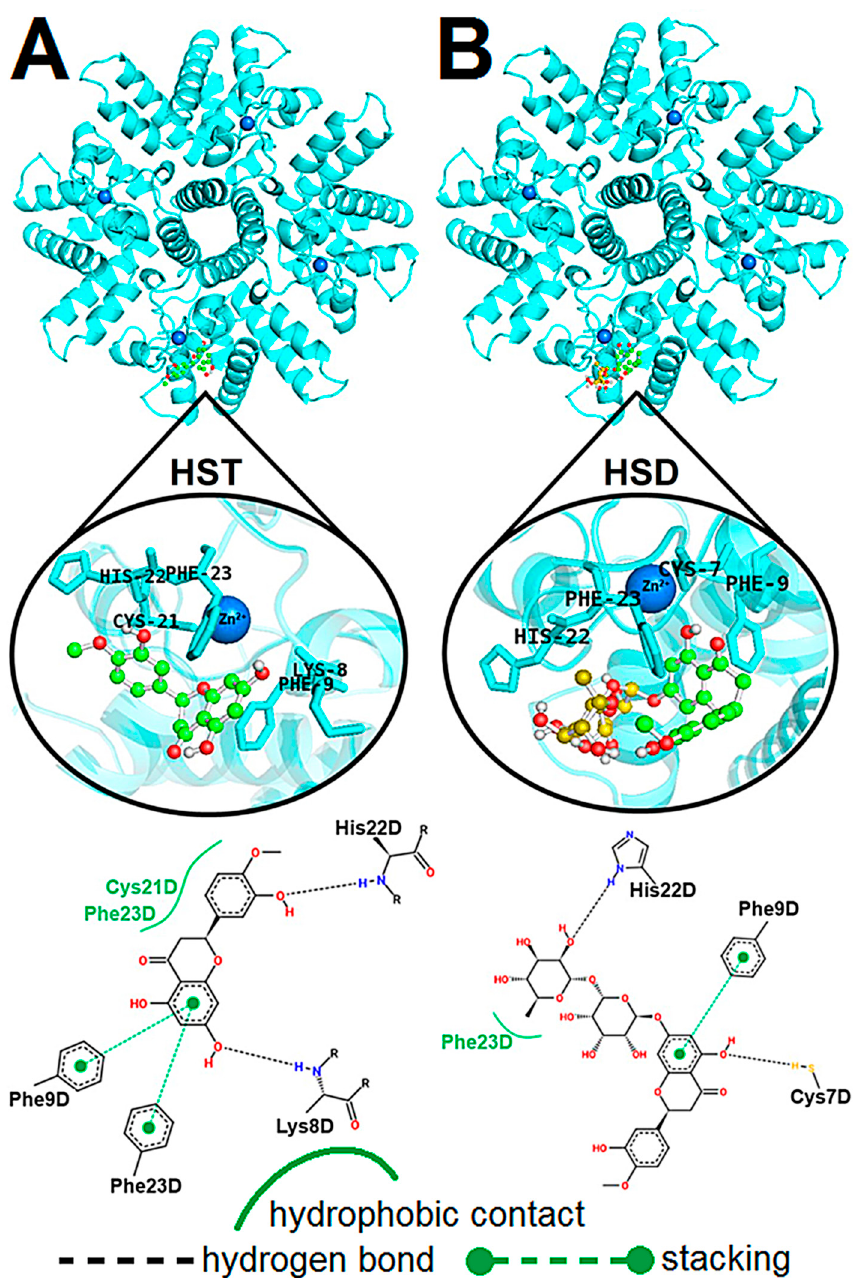
Figure 4. Possible localization of the flavonoids ( A ) HST and ( B ) HSD in the AMP-binding site of the hRSV M 2-1 protein calculated by molecular docking. At the top, the structural models of the complexes with the lowest energy conformers from the largest cluster of the docking calculations. The protein is denoted by cartoon, the zinc atoms as blue spheres, and flavonoids as sticks and balls model (C: green; O: red, H: white; C from rutinose are in yellow for HSD). In the middle, three-dimensional structural details of the binding nanoenvironment of flavonoids, highlighting the main residues of the M 2-1 protein involved in the non-covalent interactions. At the bottom, the two-dimensional representation of the interaction maps between the flavanones and residues of the M 2-1 protein. The hydrogen bonds are denoted by dotted line, stacking interaction by dotted green line, and hydrophobic contact by solid green line. The letter D at the end of the residue names depicts the tetramer chain. The structural representations were made in PyMol and the interaction maps were calculated using PoseView program.